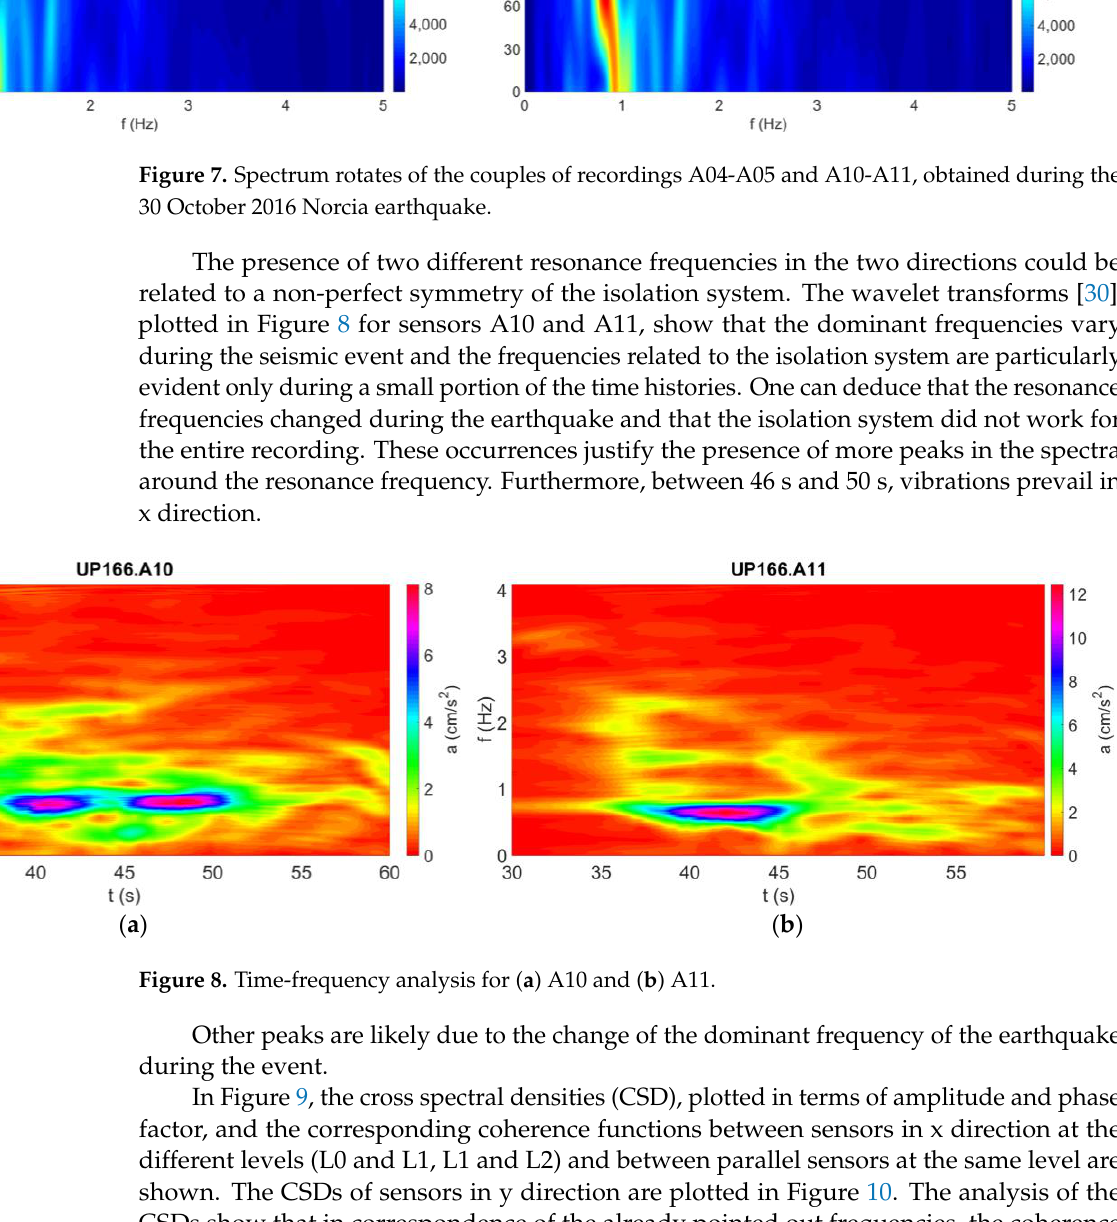
Figure 6. Fourier spectrum amplitude at different levels obtained during the 30 October 2016 Norcia Earthquake in ( a ) x direction and ( b ) y direction.